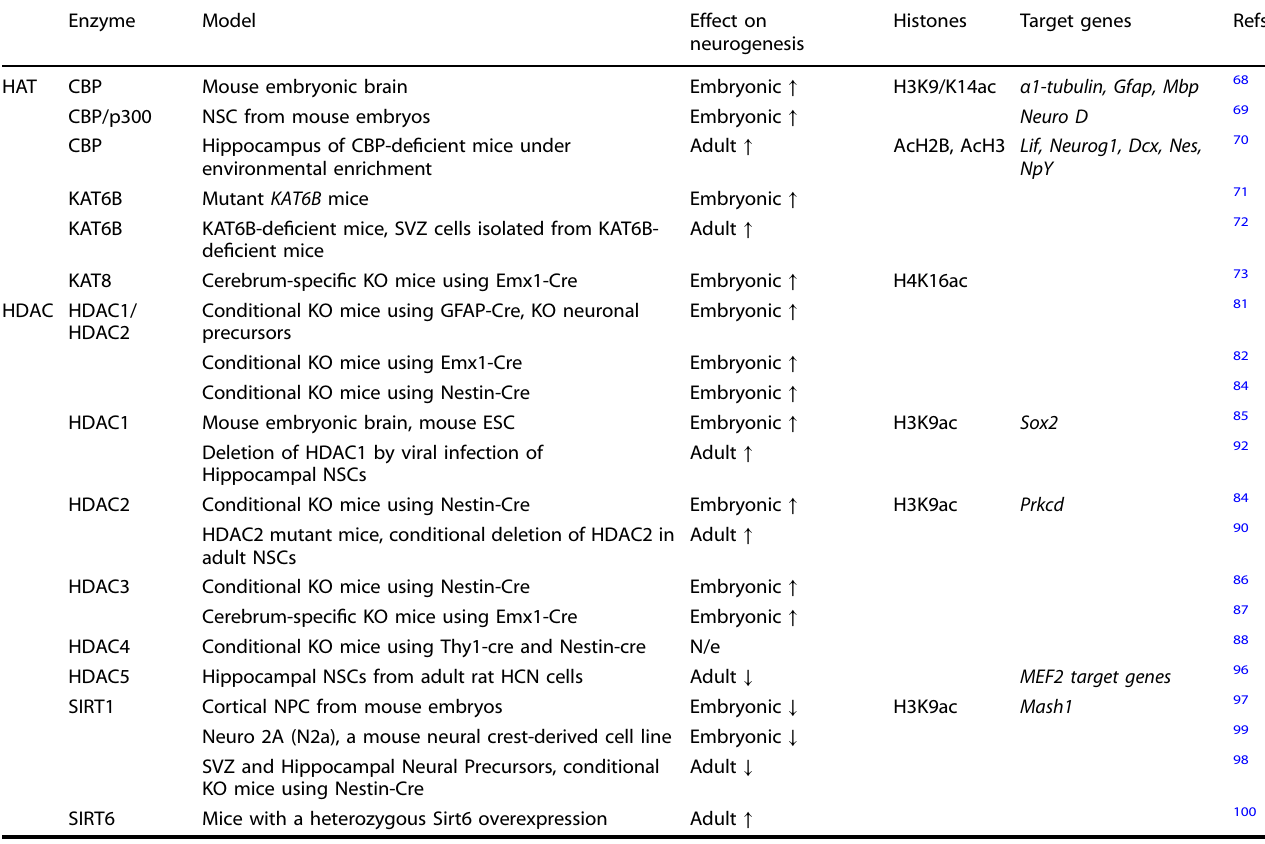
Table 2. Role of histone acetyltransferases (HATs) and histone deacetylases (HDACs) during neurogenesis Enzyme Model